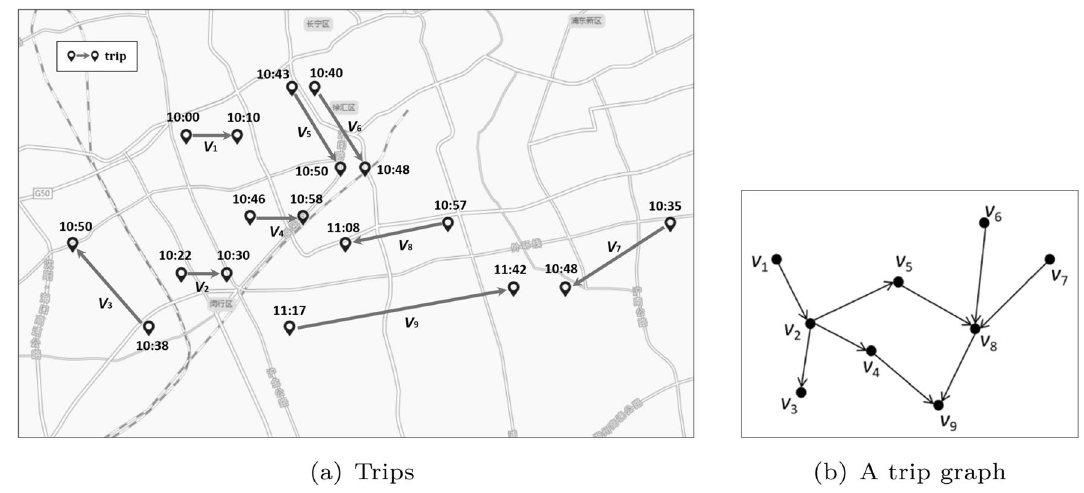
Fig. 1 An example of trips and its trip